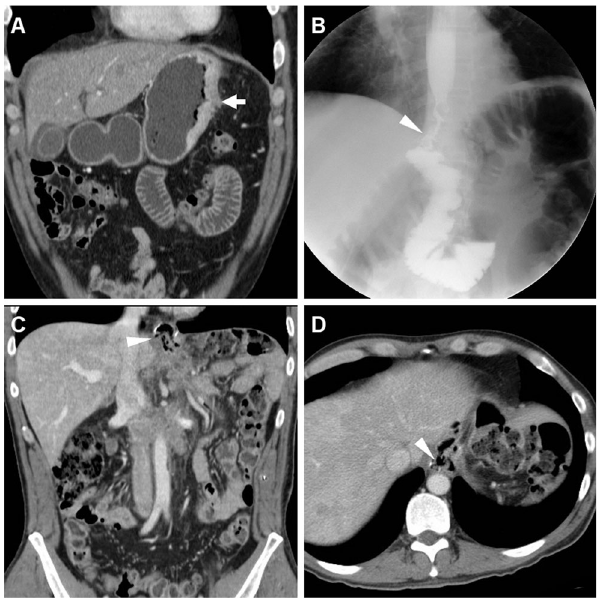
Fig. 2 In a 39-year-old male with endoscopic and bioptic diagnosis of stomach adenocarcinoma, preoperative staging CT with oral water distension (A) showed marked solid, enhancing mural thickening from the gastric fundus along the greater curvature (thick arrow). On the fifth postoperative day (POD) after uncomplicated total gastrectomy with lymphadenectomy and splenectomy, contrast fluoroscopy (CF, B) showed normally patent, thin EJS (arrowhead) with opacification of jejunal limb and no anastomotic contrast medium leakage. Corresponding expected postsurgical contrast-enhanced CT (C, D) appearances at hospital discharge included stapled EJS (arrowheads) without peri-anastomotic air or fluid, absent spleen without collections in the surgical